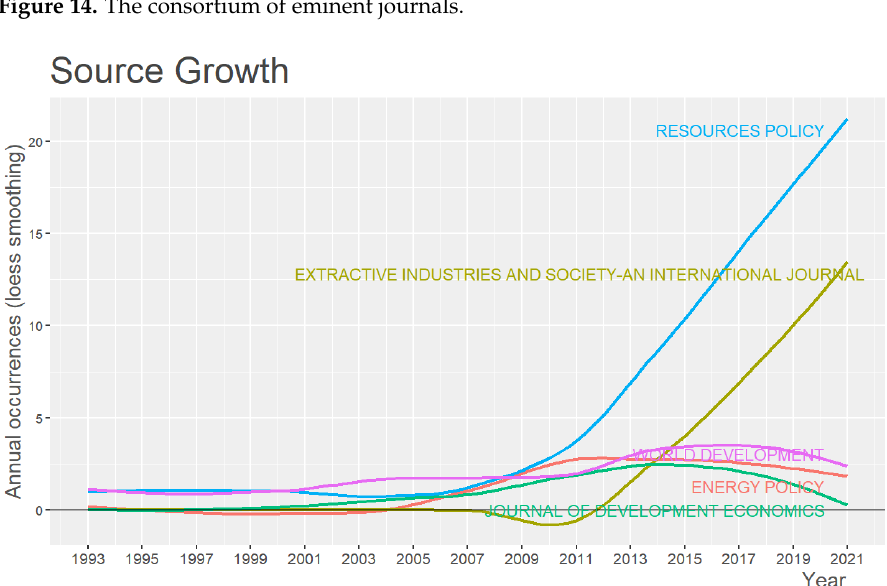
Figure 15. Annual occurrence growth of the top five journals.